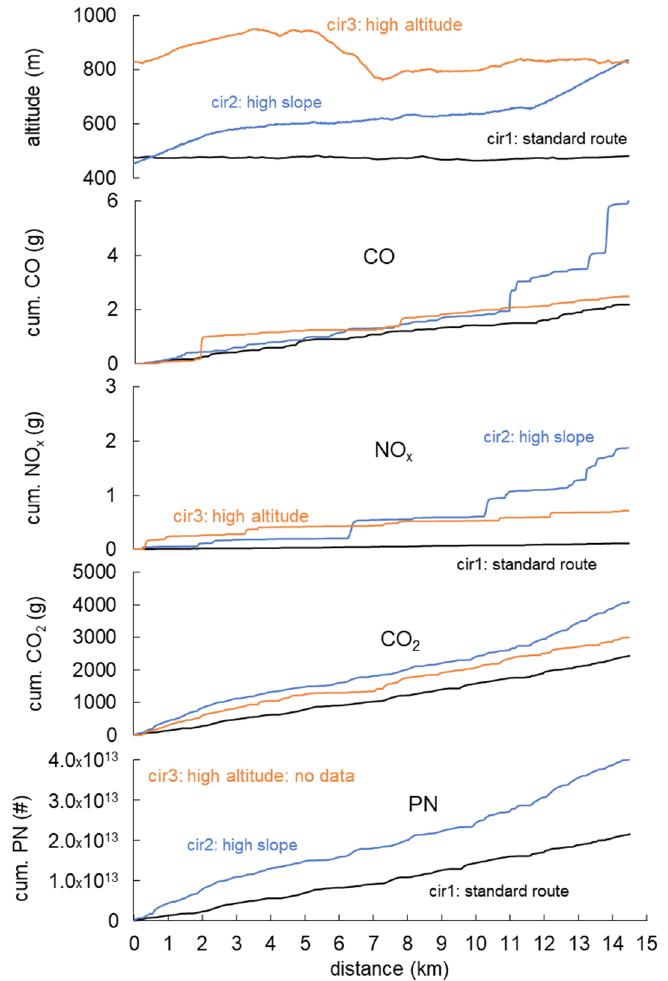
Figure 14. Influences of slope and altitude on the cumulated emissions in the selected parts of the test circuits, gasoline (V1).